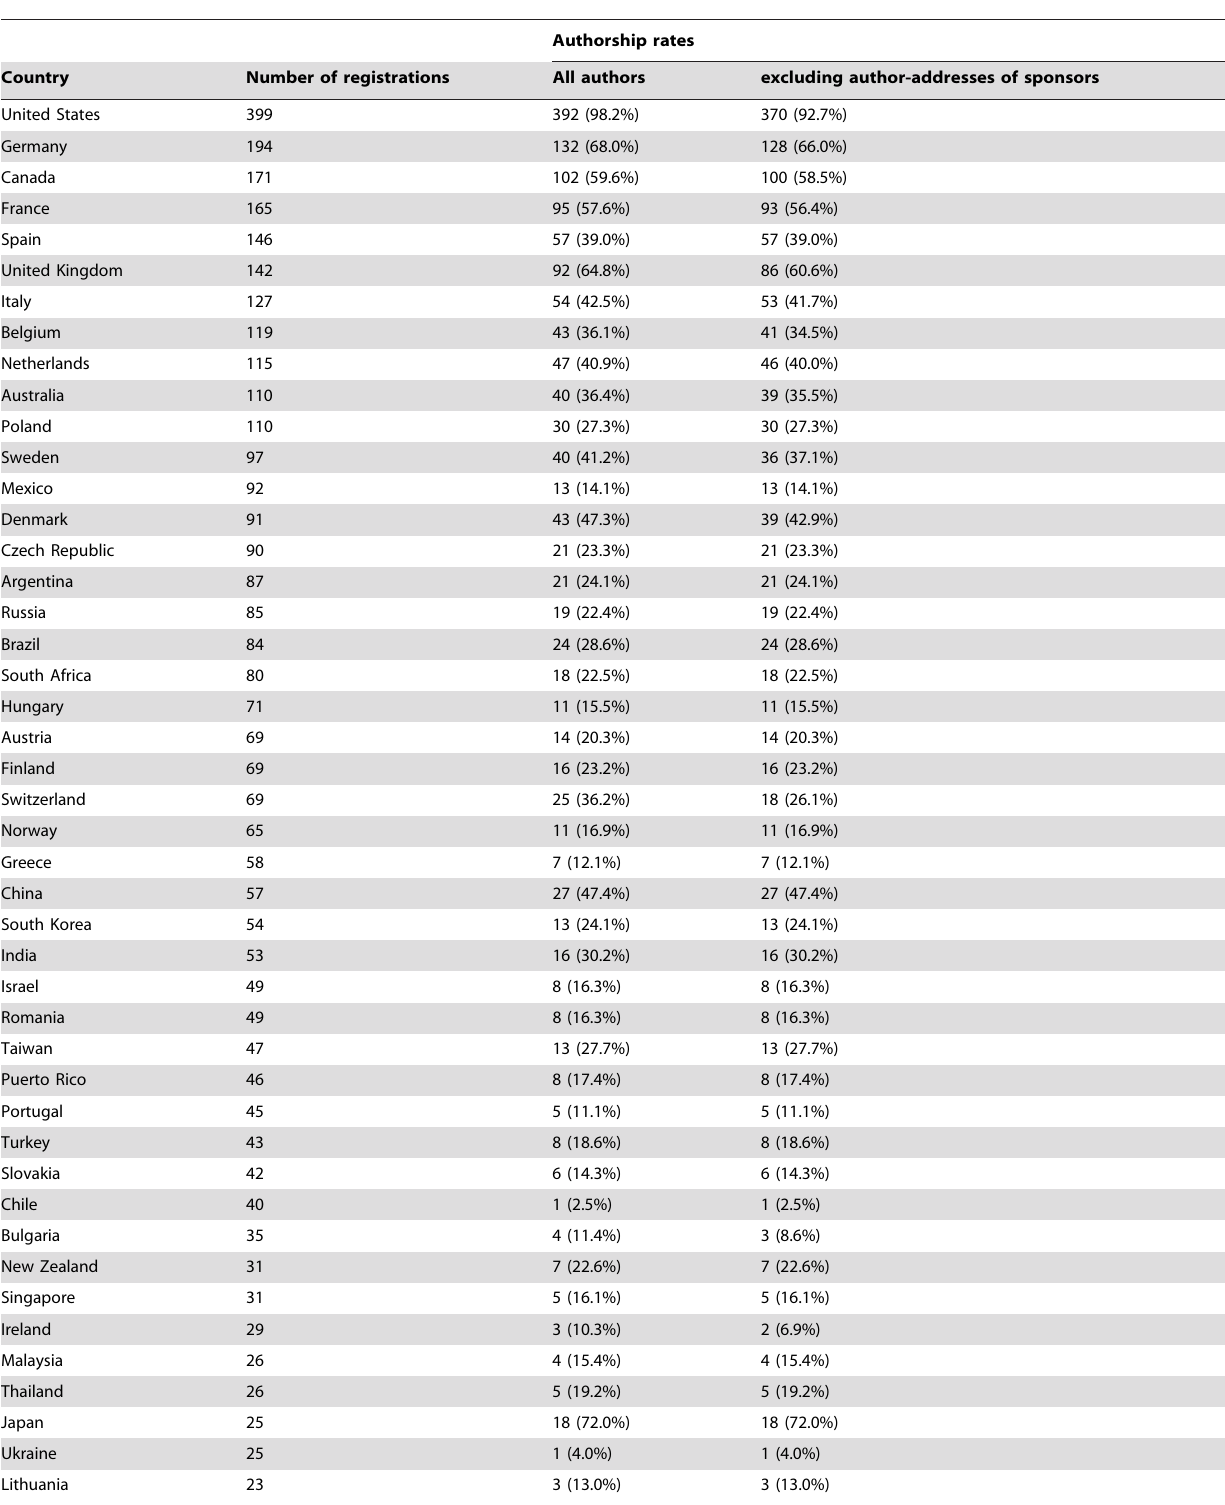
Table 2. Number of registrations and authorship rates for industry-funded trials per country for all authors and when excluding author-addresses of